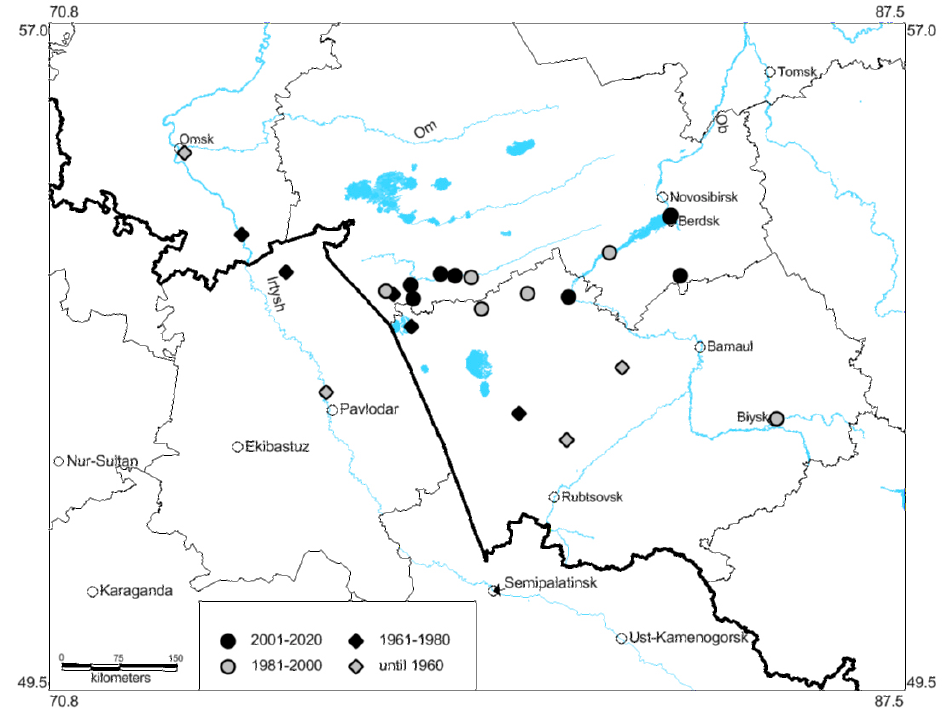
Figure 3. Typical habitats of Oedaleus decorus in the Kulunda steppe: ( A )—typical steppe (near the Kuchuck River, Altai Krai (Altaj Region), 52.41° N 80.03° E); ( B )—dry steppe (near Ust-Volchikha settlement, Altai Krai (Altaj Region), 51.93° N 80.28° E).